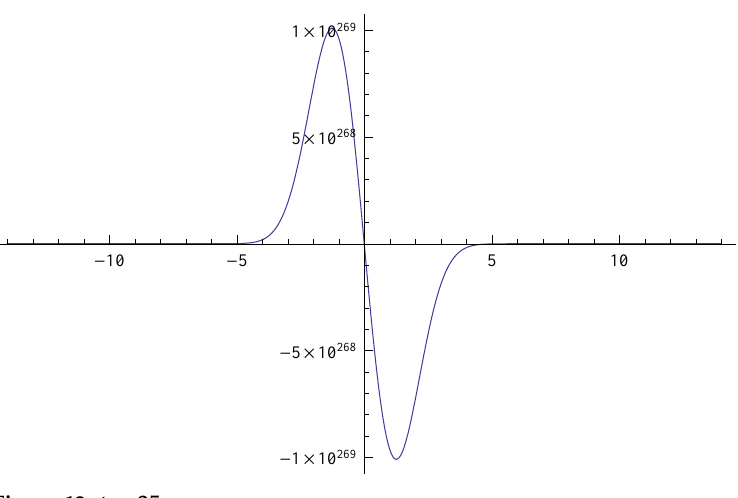
Figure 12. t = 25. The time evolution of the approximate solution of Equation (5) for a ( x ) = a = 1, b ( x ) = − bx , γ = 0.8, β = 1.7, α = 1, k = 0.7 and f ( x ) = δ ( x ) is plotted in Figures 13–16.